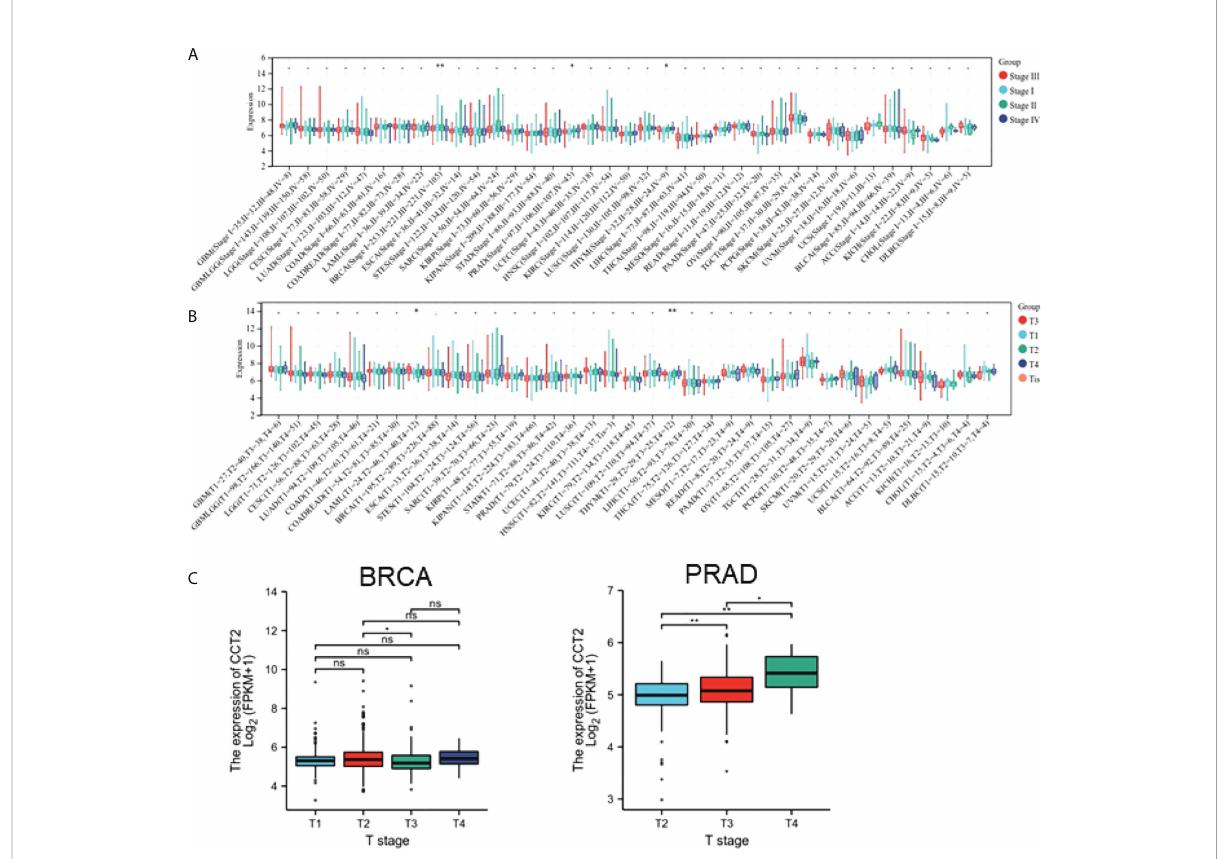
FIGURE 3 Association between CCT2 expression and clinical characteristics. (A) Association between CCT2 expression and tumor stage grading. (B) Association between CCT2 expression and BRCA and PRAD tumor stages. (C) Expression of BRCA and PRAD in different tumor stages. * p < 0.05, ** p < 0.01. NS, no signi fi